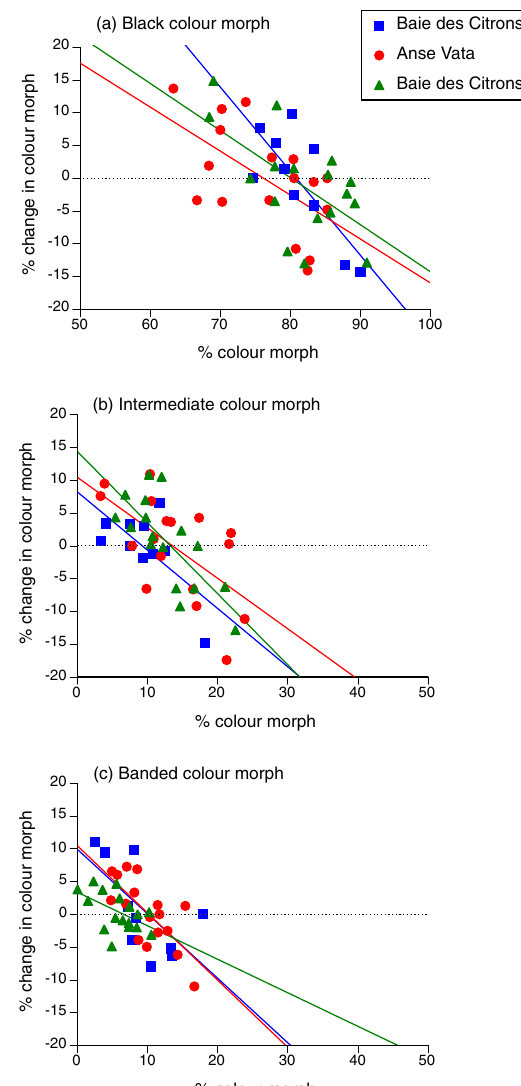
Figure 4. Negative frequency-dependent recruitment of turtle-headed sea snakes, Emydocephalus annulatus , with respect to colour morph: ( a ) black, ( b ) intermediate and ( c ) banded. The graphs show, for each colour morph, the relationship between frequency of a morph in one year (X-axis) compared to the change in that frequency during the following year (Y-axis). Regression lines are fitted to data from each of the three study